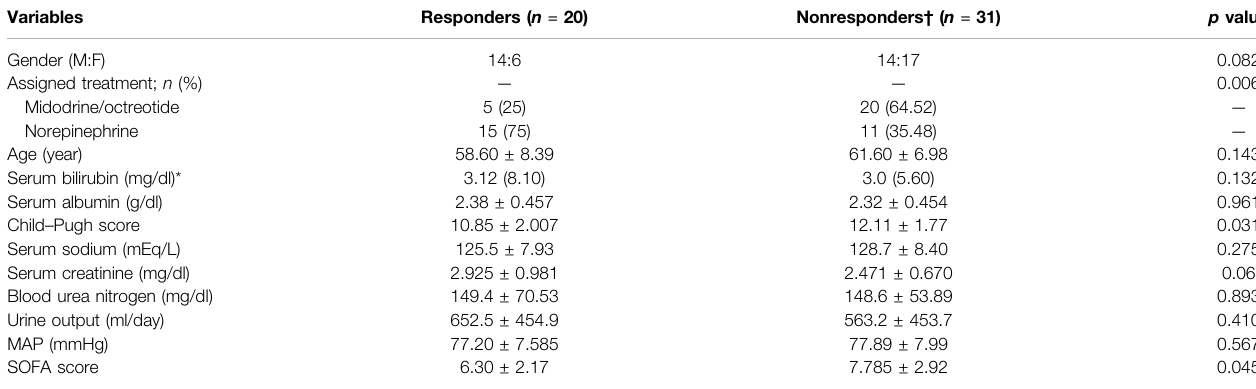
TABLE 4 | Univariate analysis of baseline variables according to response to treatment.